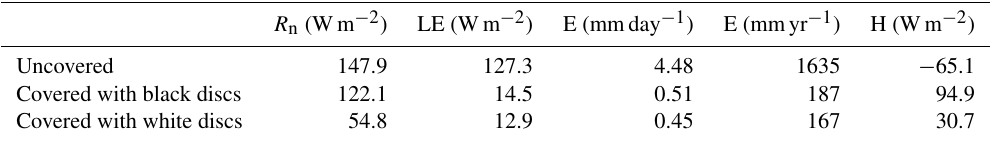
Figure 7. Measured and simulated surface temperature dynamics in lab-scale water basin. (a) Surface temperature of uncovered water basin and gaps between white and black discs obtained from IR measurements ; (b) model prediction and IR measurements of uncovered water basin surface temperature; (c, d) model predictions (solid lines) and IR measurements (dashed lines) of covers and gaps surface temperature for basin covered with black and white discs, respectively. Table 3. Modeled annual surface heat fluxes of uncovered and covered hypothetical reservoirs using meteorological data from the European Fluxes Database for Majadas, Spain (March 2004 to March 2005); Rn: net radiation, H: sensible heat flux, LE: latent heat flux, E: evaporation